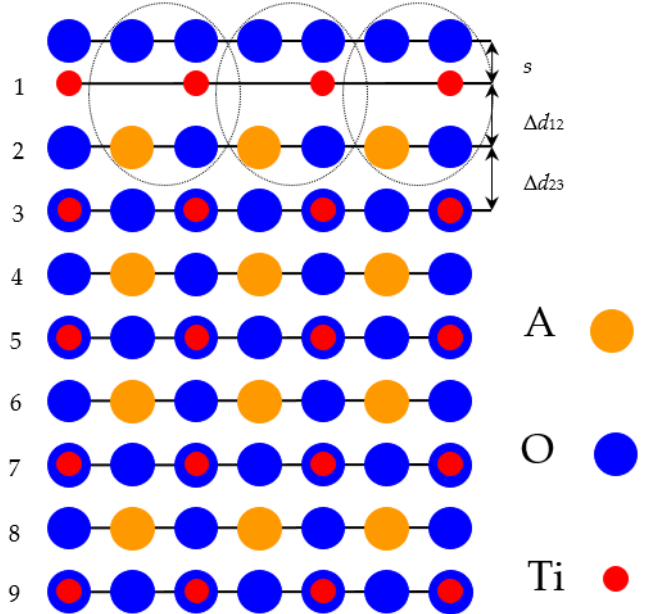
Figure 2. Side view of the nine-layer TiO 2 -terminated ATiO 3 perovskite (001) surface.